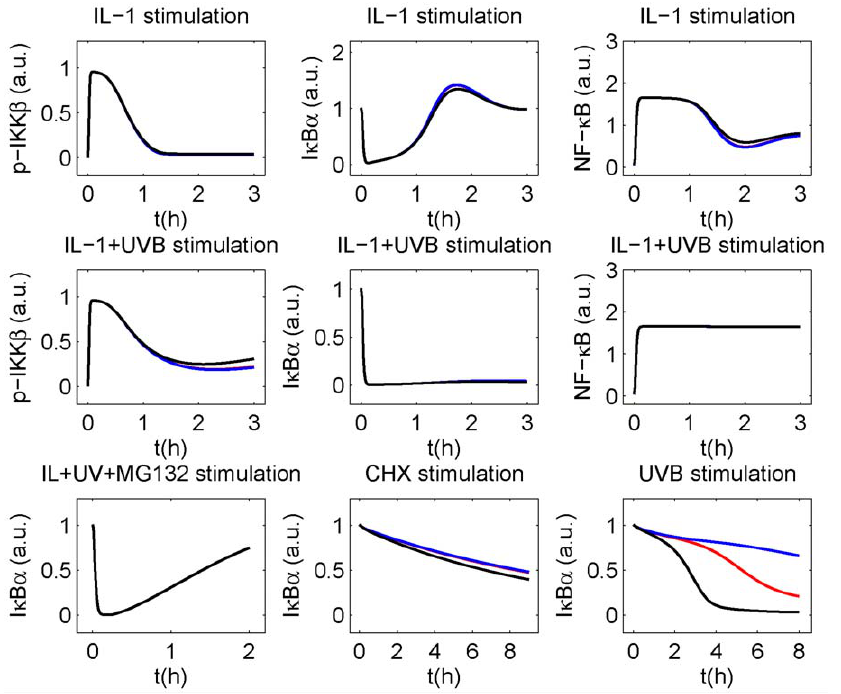
Figure 4. I k B a degradation upon UVB stimulation critically depends on constitutive IKK b phosphorylation. Model results of model M Ref for protein levels with k pconst as determined by fitting (red), ten fold larger k pconst (black) and ten fold lower k pconst (blue). For any stimulation except UVB stimulation alone, the differences are marginal.